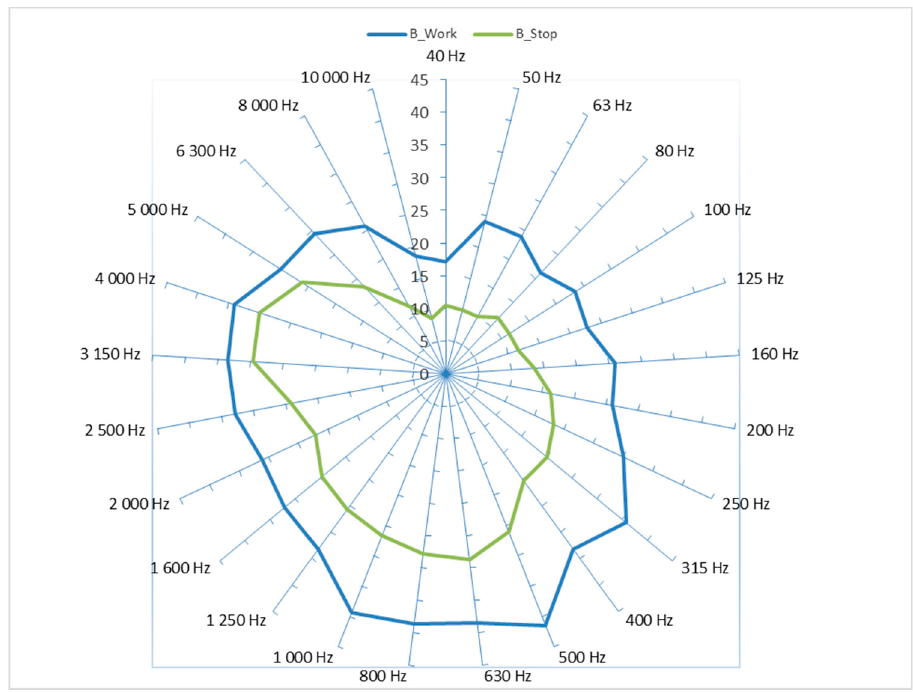
Figure 7. Values of noise emissions measured during operation (Work) and out of operation (Stop)—residential house B.